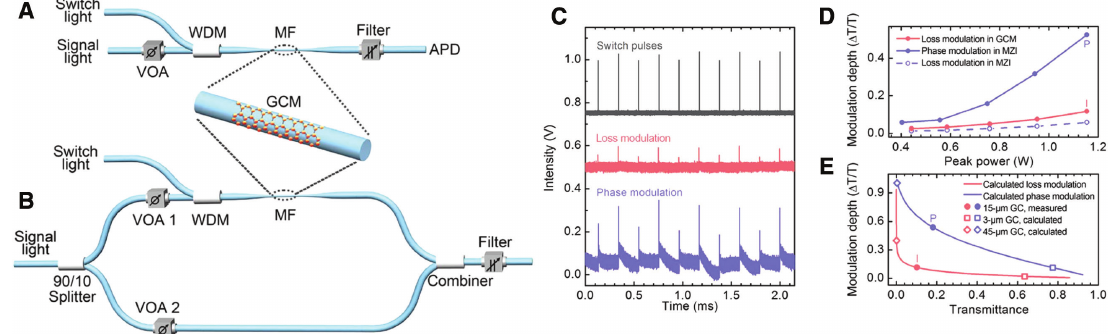
Figure 14: GCM-based all-optical modulators. (A) Schematics of GCM-based all-optical modulators based on optically induced loss modulation in a GCM. (B) Schematics of GCM-based all-optical modulators based on optically induced phase modulation in a GCM in one arm of an all-fiber MZI. (C) Top panel, pairs of switching pulses; middle panel, pulse-modulated signal from a GCM-contained fiber; bottom panel, pulse-modulated signal from an MZI as a result of phase modulation in the GCM-contained arm. (D) Modulation depth of the output signal as a function of the peak switching power for the GCM-contained fiber modulator (red solid line), for the MZI modulator (blue solid line), and for the MZI modulator with only loss modulation in the GCM-contained arm of the MZI (blue dashed line). (E) Modulation depth versus overall transmittance (OT) for the GCM-contained fiber modulator (red line) and the MZI modulator (blue line) with different graphene cladding lengths as indicated. Reproduced with permission [268]. Copyright 2016, The Optical